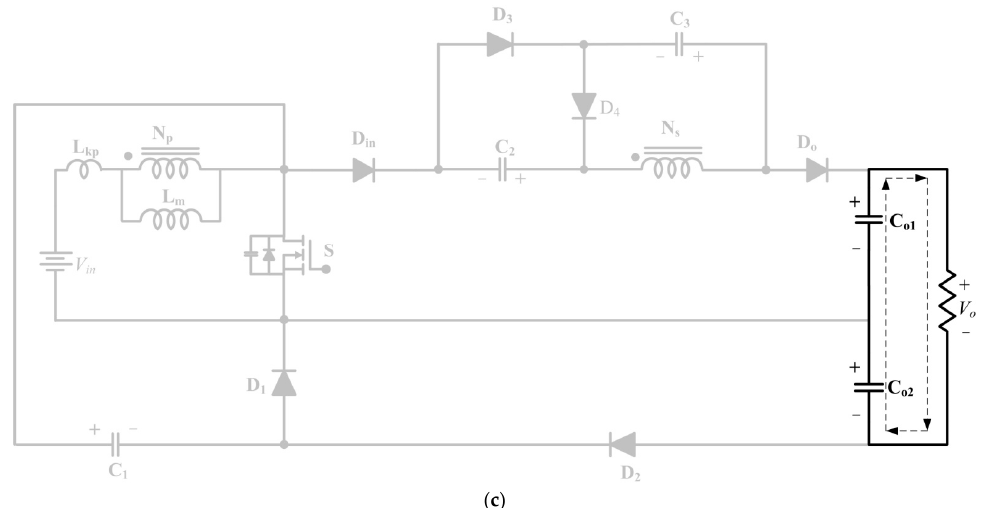
Figure 6. Operating modes at DCM during a switching period. ( a ) Modes I; ( b ) Modes II; and ( c ) Modes III.